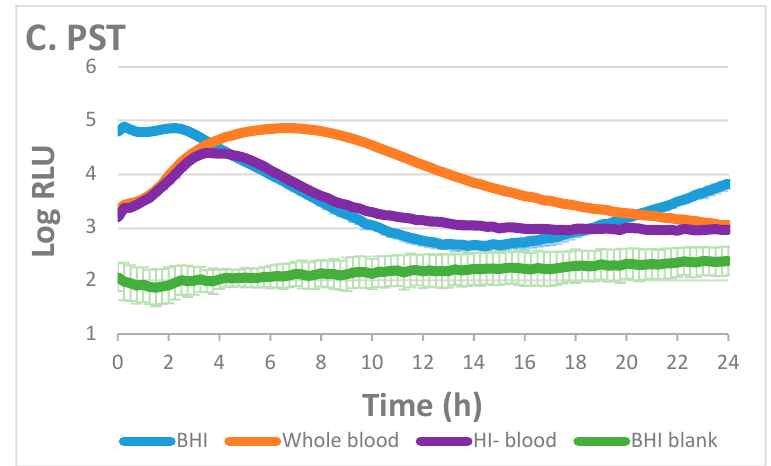
Figure 3. Lysis of EV76:: lux in BHI, whole blood and HI-blood by Y. pestis phages. A bioluminescence lysis assay was performed with 10 7 CFU/mL EV76:: lux spiked in BHI, human whole blood or HI-blood. The bioluminescence assays were assessed without phage ( A ) or with ϕ A1122 ( B ) or PST phage ( C ) at MOI = 0.01. The experiment was performed using 6 different blood donors (of various blood types), and the results are representative of one blood donor (blood type O+, 9 days from uptake). Values are the average relative light units (RLU) results from 3 wells triplicate in the same experiment, and the error bars represent the standard deviation (STDEV).